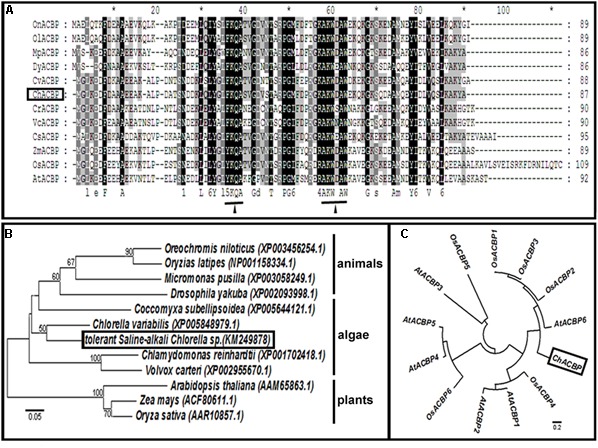
Phylogenetic and sequence analyses of acyl-CoA-binding protein 1 (ChACBP1) from saline-alkali-tolerant Chlorella. (A) Sequence alignment of ACB domain from ChACBP1 with those of other species. YKQA and KWDAW motifs are underlined; capital letters indicate identical residues in all ACBPs; small letters indicate residues identical in most ACBPs (arrowheads). Black background indicates conserved residues. On, Oreochromis niloticus; Ol, Oryzias latipes; Mp, Micromonas pusilla; Dy, Drosophila yakuba; Cv, Chlorella variabilis; Ch, Saline-alkali-tolerant Chlorella sp.; Cr, Chlamydomonas reinhardtii; Vc, Volvox carteri; Cs, Coccomyxa subellipsoidea; Zm, Zea mays; Os, Oryza sativa; At, Arabidopsis thaliana; ChACBP1 is indicated in boldface in box. (B) Neighbor-joining (NJ) phylogenetic relationships among acyl-CoA-binding protein (ChACBP) from saline-alkali-tolerant Chlorella and various ACBPs from other species. Bootstrap values were calculated 1,000 times; values < 50% are not shown. Saline-alkali-tolerant Chlorella is indicated in boldface in box. GenBank accession numbers are as follows: OnACBP (XP_003456254.1), OlACBP (NP_001158334.1), MpACBP (XP_003058249.1), DyACBP1 (XP_002093998.1), CvACBP1 (XP_005848979.1), ChACBP (KM249878), CrACBP (XP_001702418.1), VcACBP (XP_002955670.1), CsACBP (XP_005644121.1), ZmACBP (ACF80611.1), OsACBP (AAR10857.1), and AtACBP (AAM65863.1). (C) Neighbor-joining phylogenetic relationships among ChACBP and members of ACBP families in Arabidopsis thaliana and rice. Box indicates ChACBP.